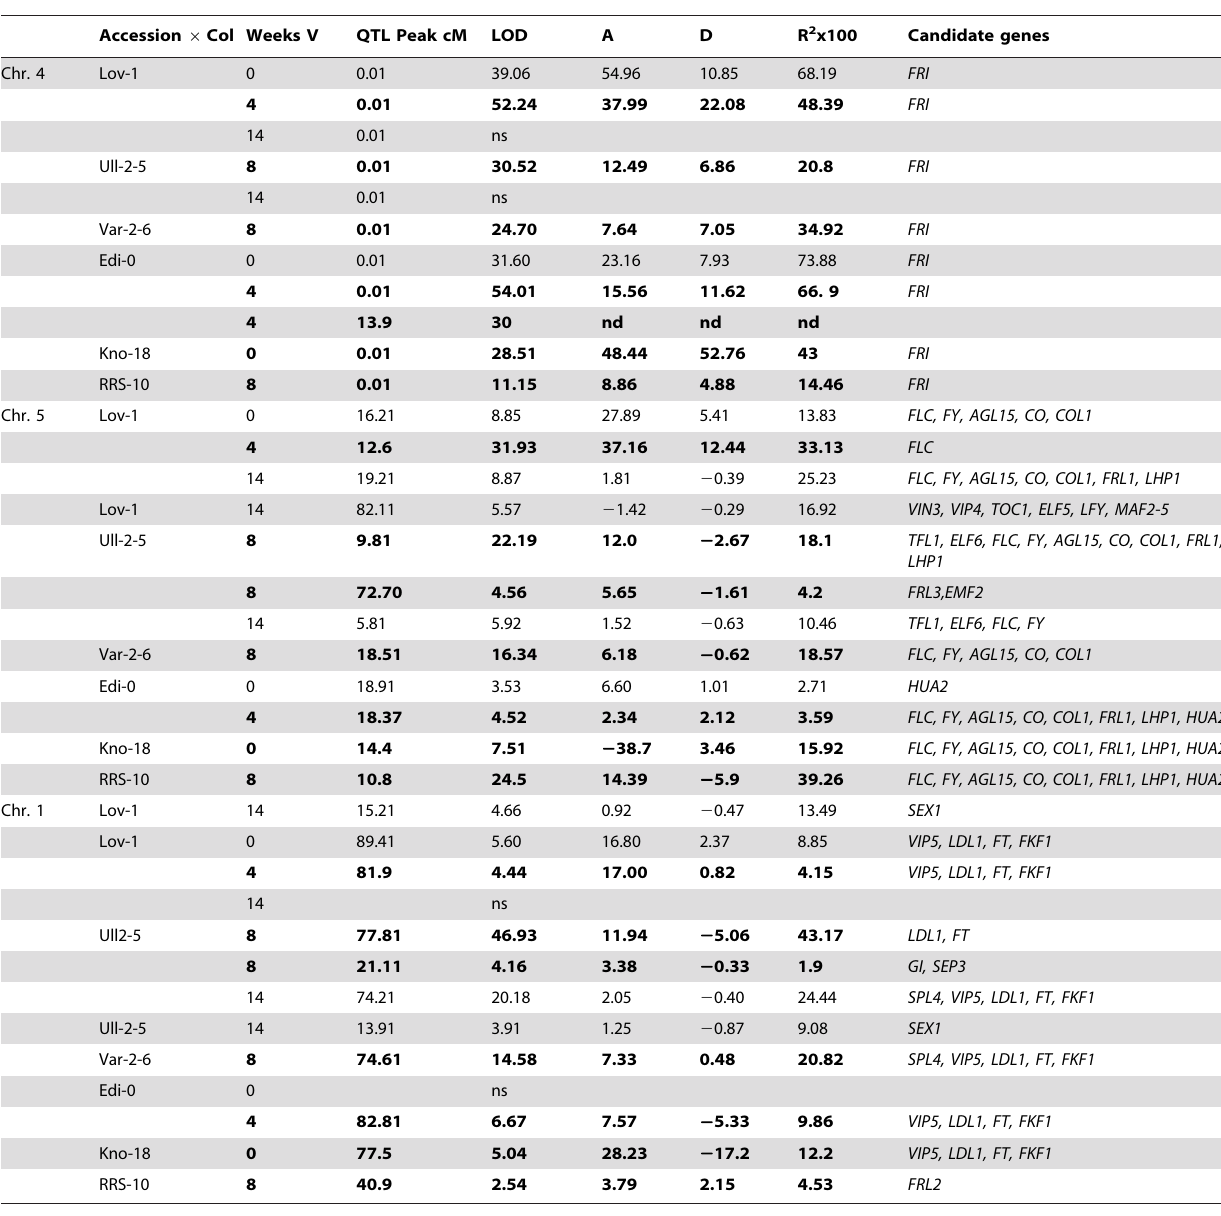
Table 1. QTL characteristics and candidate genes mapping to the